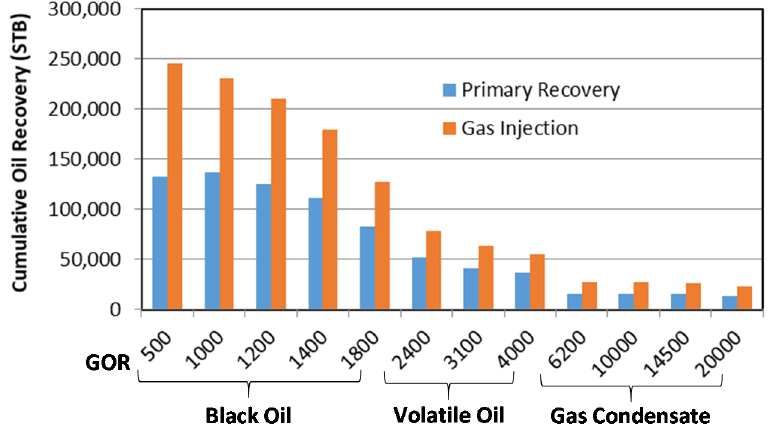
Figure 14. Cumulative oil recovery from primary production and from gas injection as a function of initial GOR.